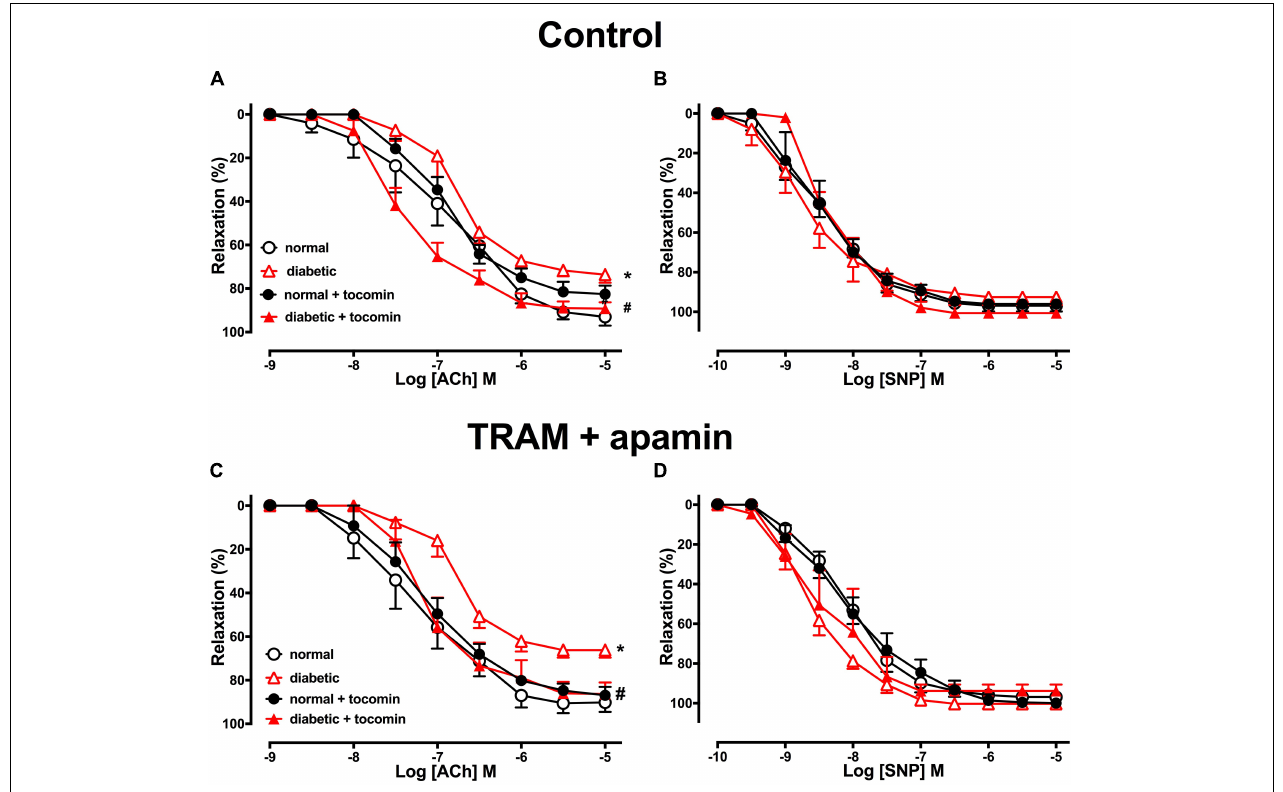
FIGURE 2 | Cumulative concentration–response curves to ACh and SNP in endothelium-intact aortae isolated from normal, diabetic, and tocomin treated (normal + tocomin/diabetic + tocomin) rats in control (A,B) and in the presence of Tram + apamin (C,D) . ∗ R max Significantly different to normal. # R max Significantly different to diabetic. P < 0.05. Data is expressed as mean ± SEM. Sidak’s multiple comparison test. n = 3–7. See Table 2 for values and statistical